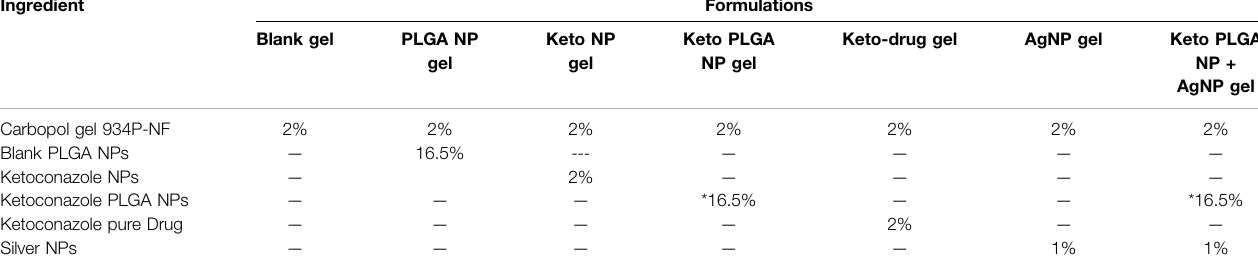
TABLE 3 | Various formulations of Carbopol 934P-NF containing ketoconazole and silver nanoparticles.